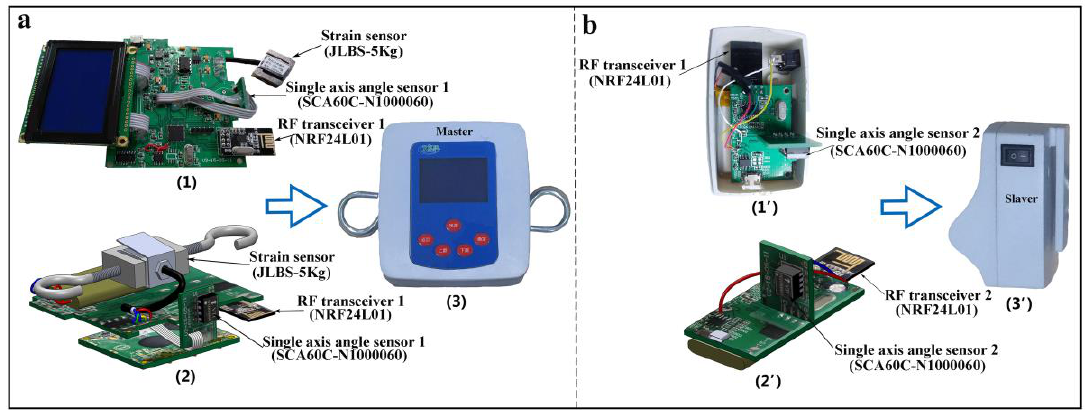
Figure 2. Photos of the measurement device and the corresponding electronic components. ( a ) The electronic components of the Master unit; ( b ) the electronic components of the Slaver